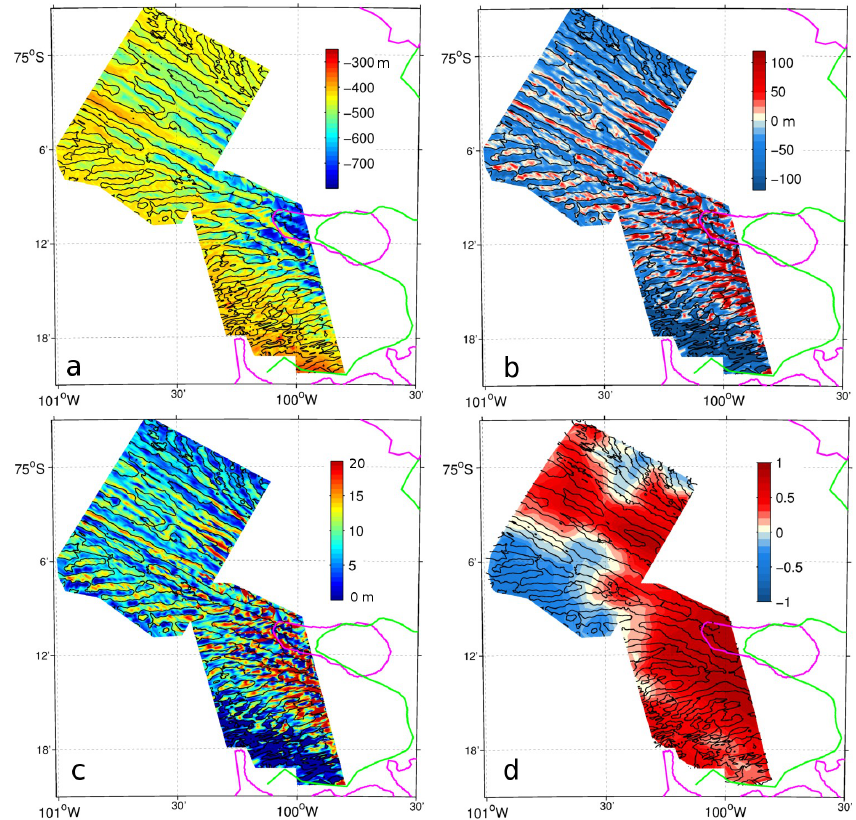
Fig. 6. (a) Ice base elevation from airborne radar observations assuming 10m air thickness in the firn, and interpolated on the SPIRIT grid, overlaid with 0m contour of the corresponding small-scale surface elevation anomaly. Same contour applies to all panels. (b) Departure from hydrostatic equilibrium, or difference between base elevation in (a) and base elevation deduced from the surface assuming flotation and constant ice density of 918kgm − 3 (i.e. no air). (c) Air thickness (Holland et al., 2011) necessary for hydrostatic equilibrium assuming air density of 2kgm − 3 and constant geoid anomaly from WGS84 of − 26m. (d) Correlation over moving 4km 2 square boxes between departure from hydrostatic equilibrium (c) and small-scale surface elevation anomaly (black contours). Note that a very similar result applies for the correlation between air thickness and small-scale surface elevation anomaly.